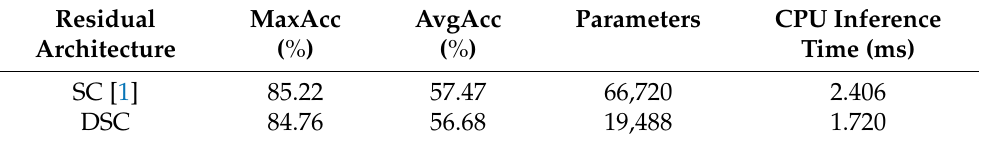
Table 6. Performance comparison between DSC and SC on RadioML2016.10A dataset.